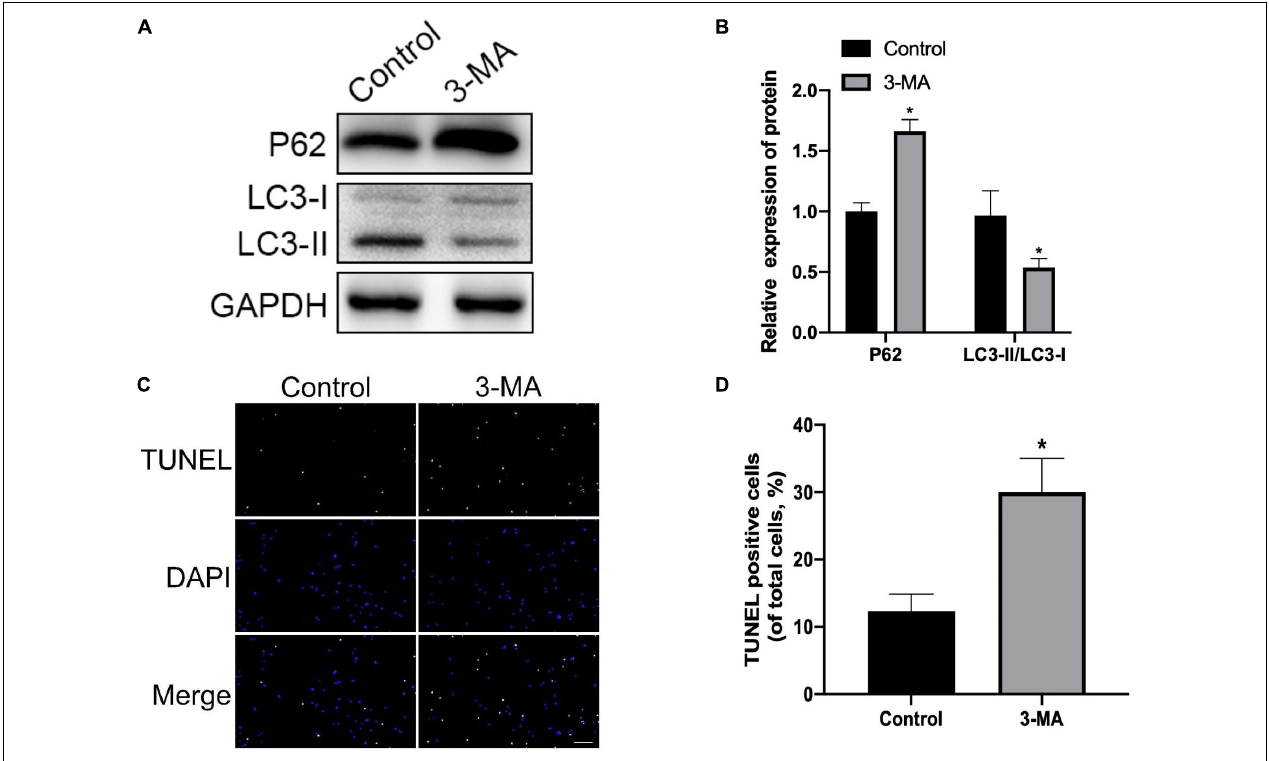
FIGURE 5 | Mitophagy inhibition enhances H 2 O 2 -induced apoptosis in rat NP. (A,B) Western blot of P62, LC3-I, and LC3-II expression in NP cells after treatment with 3-MA. (C,D) Representative images of TUNEL staining and quantitative analysis showing NP cells apoptosis after treatment with 3-MA. * p < 0.05 vs. control